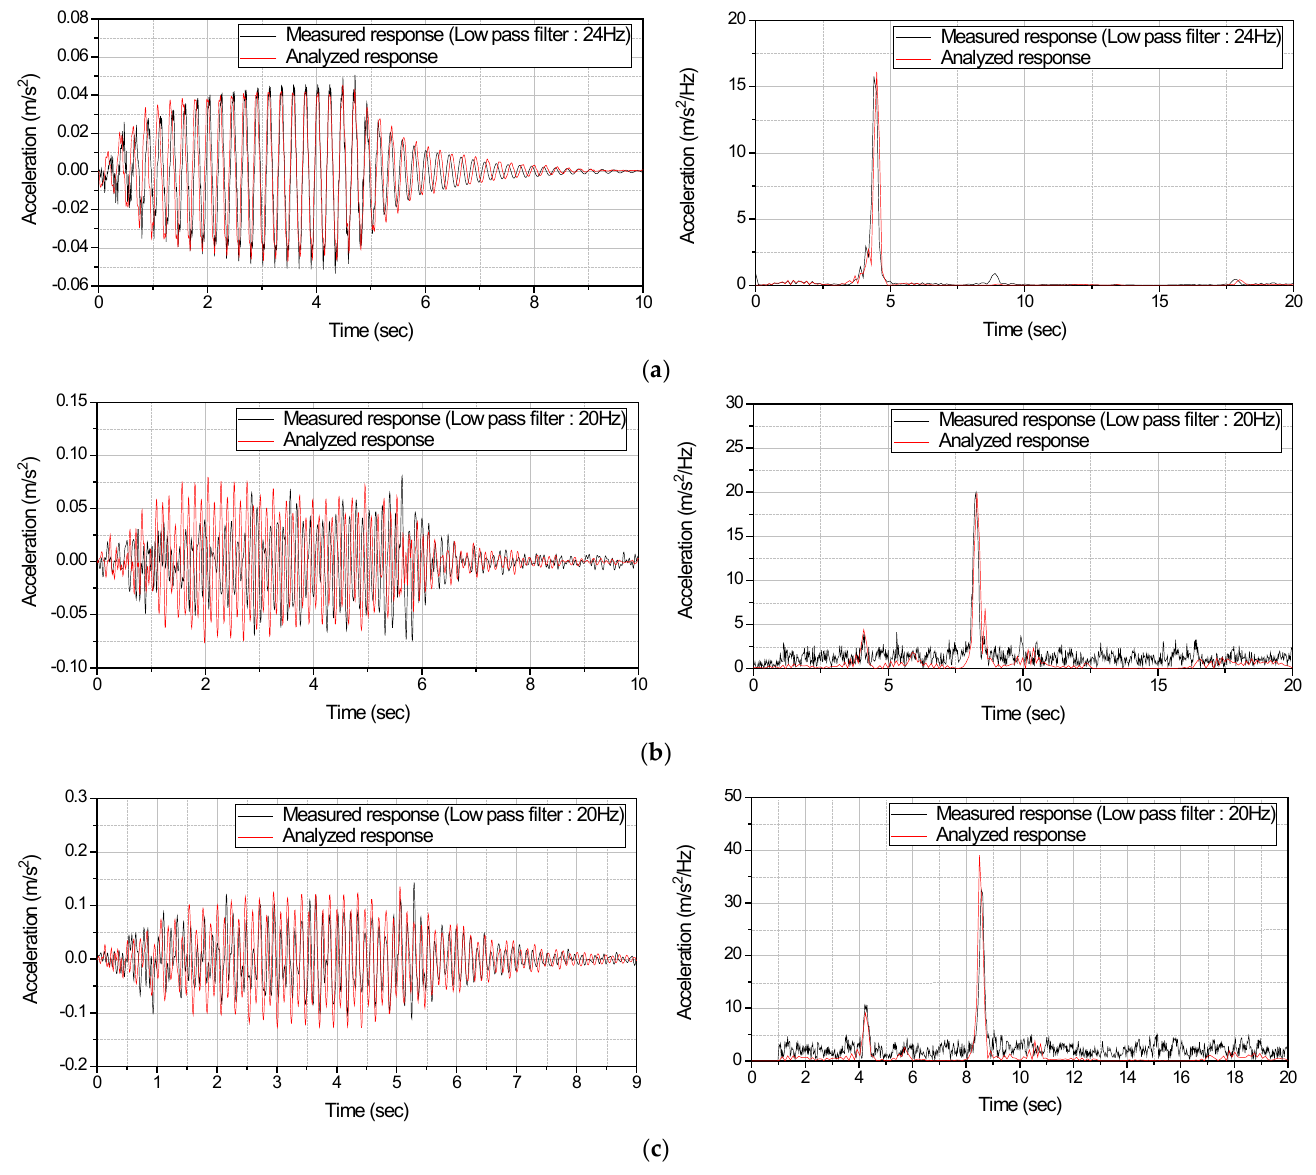
Figure 8. Comparison of the measured and analyzed responses from the target bridges: ( a ) Imgi 2nd Bridge; ( b ) Maeaji Bridge; ( c ) Hwalchun Bridge.